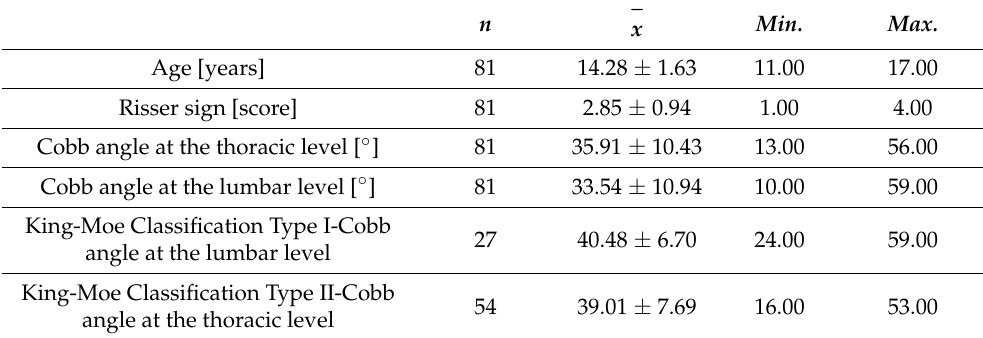
Table 2. Age and X-ray analysis of